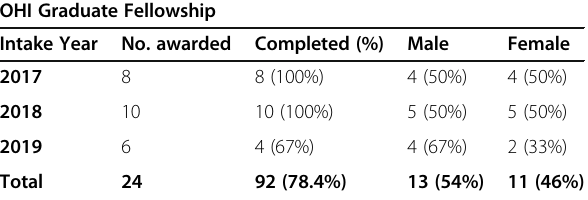
Table 2 Summary of graduate